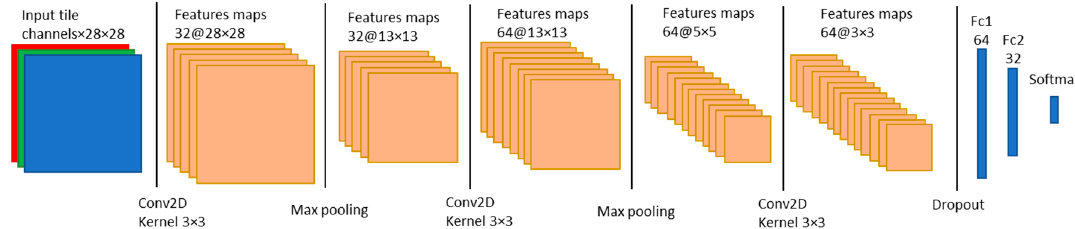
Figure 3. Representation of the convolutional neural network architecture used in this work. This architecture comprises 93.954 training parameters. See main text for details (colors used for better visualization).